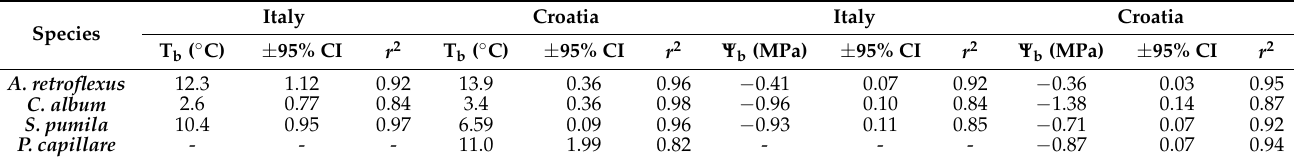
Table 3. Base temperature (T b ) and base water potential ( Ψ b ) of weed species for the Italian and Croatian populations, with the confidence interval (95% CI) and coefficient of determination ( r 2 ). The Italian germination parameters for the three weed species ( A. retroflexus , C. album , and S. pumila ) were estimated by Masin et al. [1]. Italy Croatia Italy Croatia Species